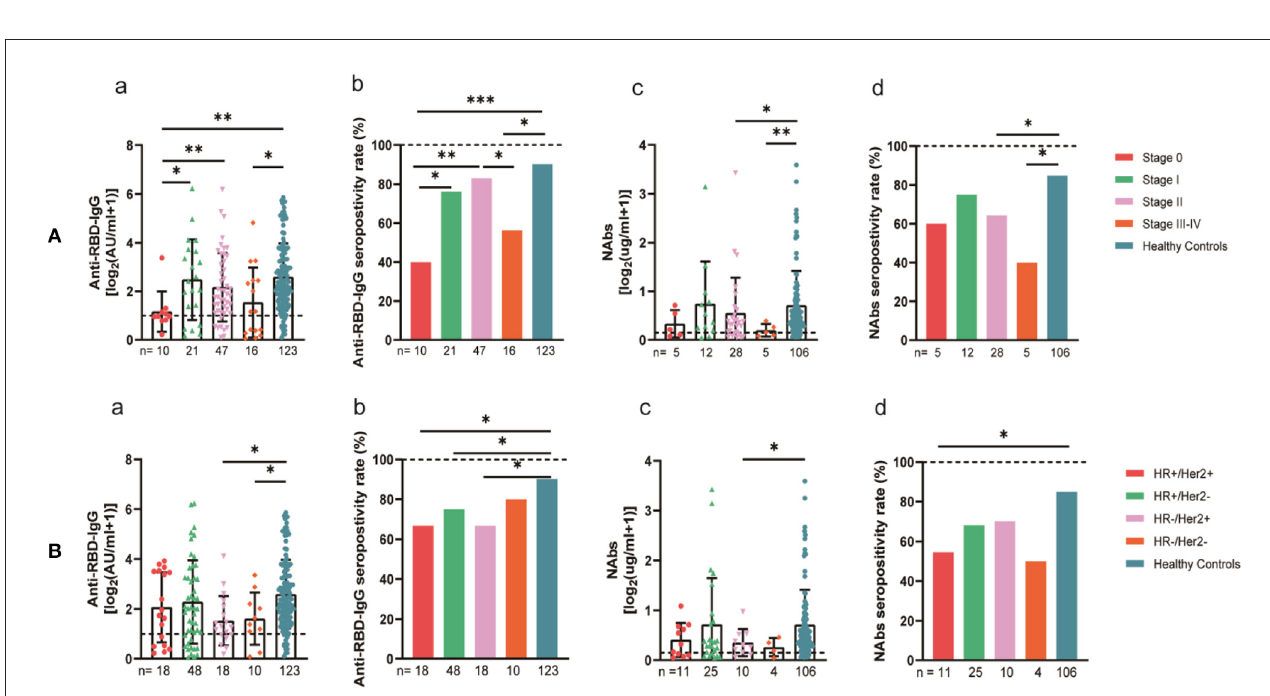
FIGURE7 Antibody response to SARS-CoV-2 vaccine in breast cancer patients. (A) Antibody response to SARS-CoV-2 vaccine in breast cancer patients at the AJCC stages. (B) Antibody response to SARS-CoV-2 vaccine in breast cancer patients with different molecular typing. Subgroup analysis of the titers and seropositivity rate of anti-receptor binding domain (RBD)-IgG (a, b) and NAbs (c, d) in breast cancer participants. The horizontal dotted lines represent the limit of detection. The error bars represent the median (IQR) (* P < 0.05, ** P < 0.01, *** P < 0.001). HR, hormone receptor; Her2, human epidermal growth factor receptor 2; NAbs, neutralizing antibodies; IQR, interquartile range; RBD, receptor binding domain.